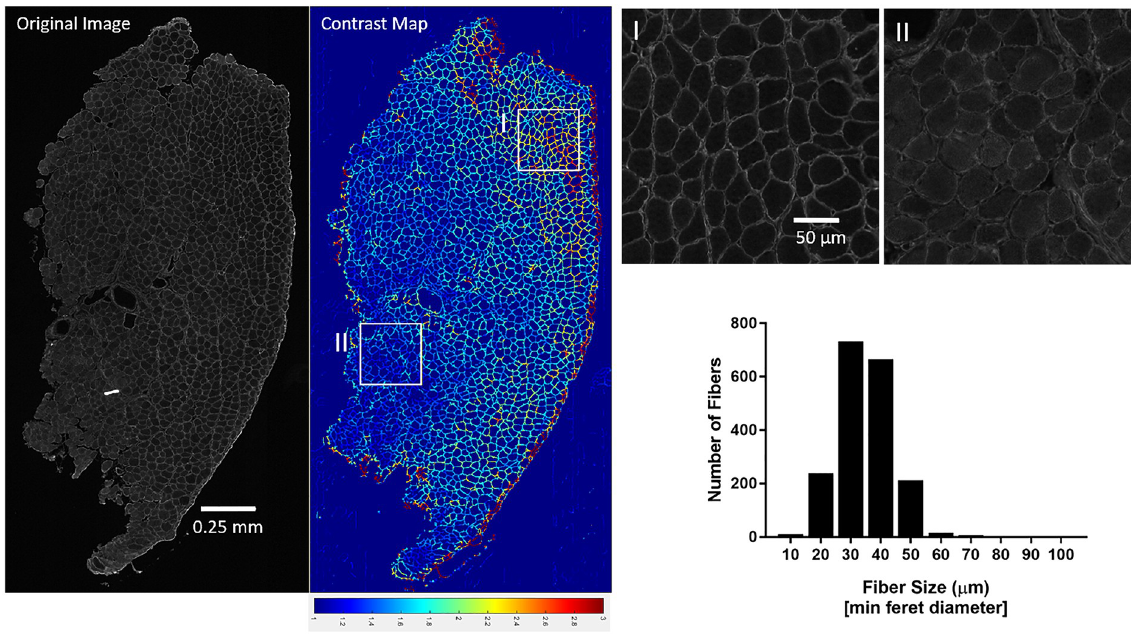
Fig 6. Development of contrast mapping tool to assess staining uniformity and contrast required for accurate fiber segmentation illustrating regions of high contrast (I) vs poor contrast (II) fiber staining. Contrast map range 1.0–3.0.